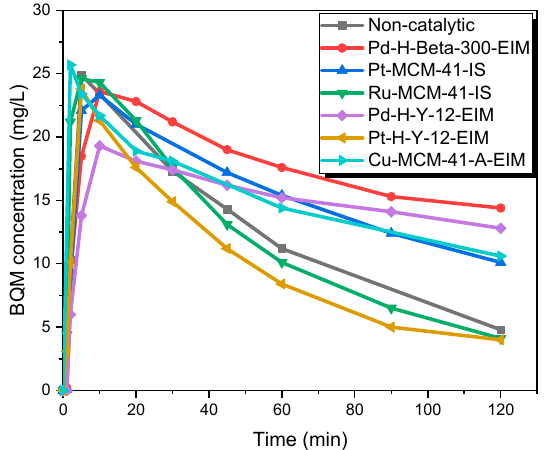
Figure 8. BQM concentration during the catalytic and non-catalytic ozonation of CBZ. C CBZ = 35 mg/L, gas flow rate = 110 mL/min, T = 20 °C, stirring speed = 900 rpm, C O3,g = 21 mg/L, C catalysts = 0.5 g/L.